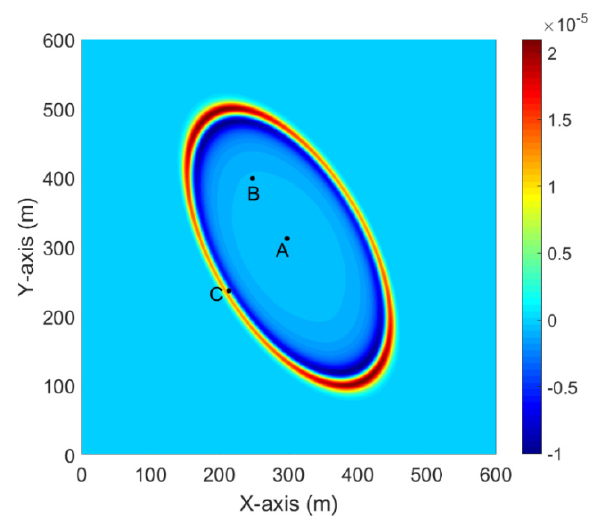
Figure 14. Magnetic field H z at time step 2000 for a medium with anisotropic electric permittivity and conductivity, and magnetic permittivity and conductivity. The principal axes were rotated by 120° with respect to the Cartesian ones. Node size is 1 m for the x and z directions and 0.5 m for the y direction . The time step used is one-half of that used for the example in Figure 11; therefore, both Figures represent the same instant.